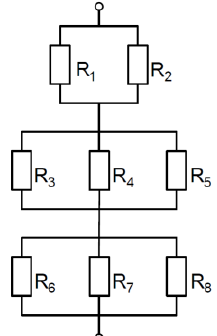
Figure 5. Energies 2020 , 13 , x FOR PEER REVIEW